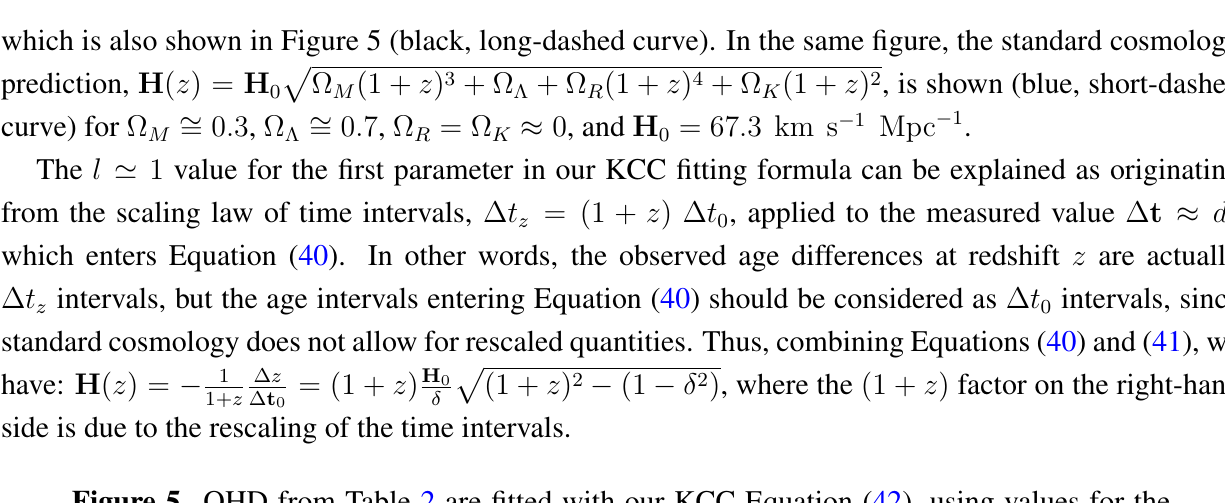
Figure 5. OHD from Table 2 are fitted with our KCC Equation (42), using values for the parameters as in Equation (43) (red-solid curve), or as in Equation (44) (black, long-dashed curve). Also shown is the standard cosmology prediction (blue, short-dashed